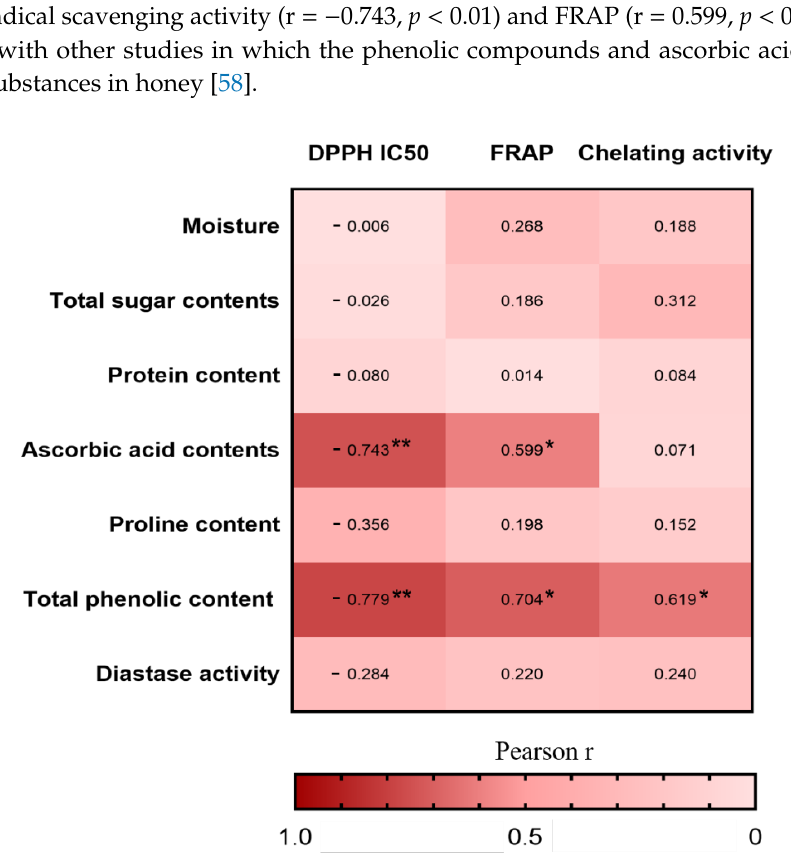
Figure 4. Heatmap analysis of the Pearson correlation between nutritional composition and antioxidant capacity in vitro. The values and intensity of the colors represent the degree of association between nutritional composition and antioxidant capacity in vitro. Statistical significance was measured by one-way ANOVA with the Tukey tests for multiple-group comparisons. * p < 0.05 and ** p < 0.01.